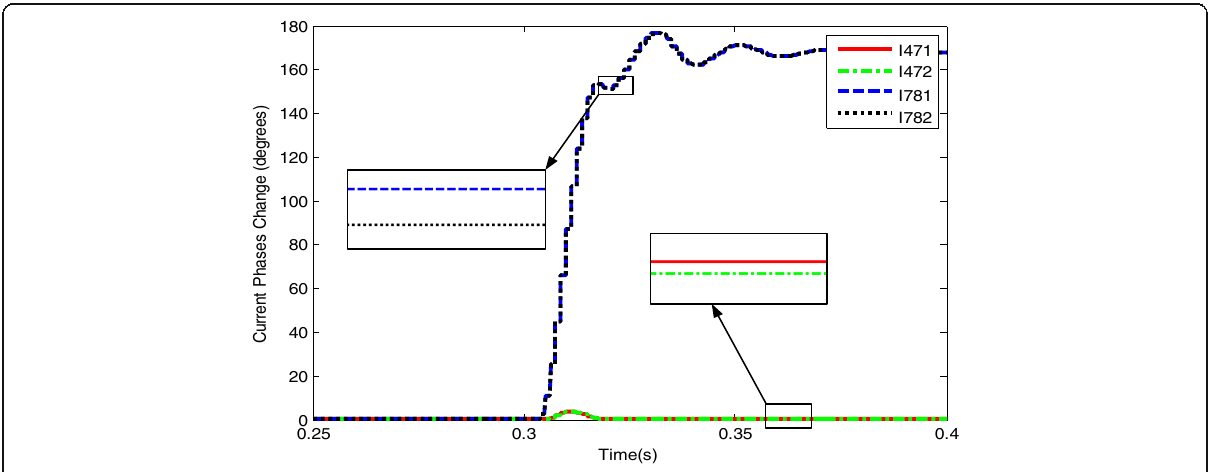
Fig. 7 Current phase changes of fault power path (F2 and